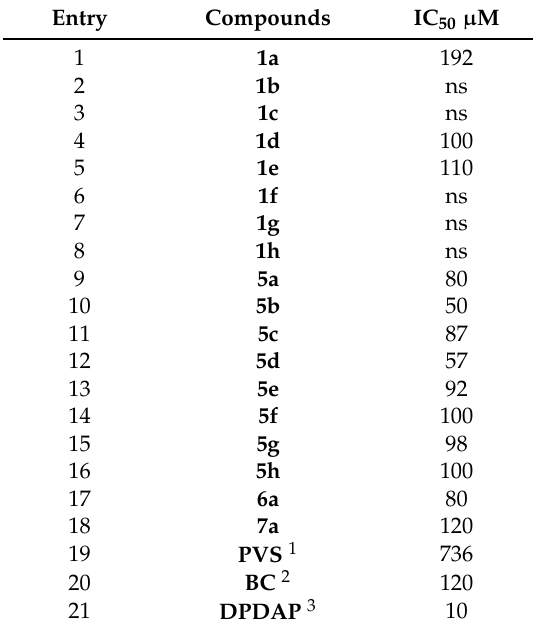
Table 1. Activity as sortase A inhibitors of compounds 1a – h , 5a – h , 6a , 7a . Entry Compounds IC 50 µ M